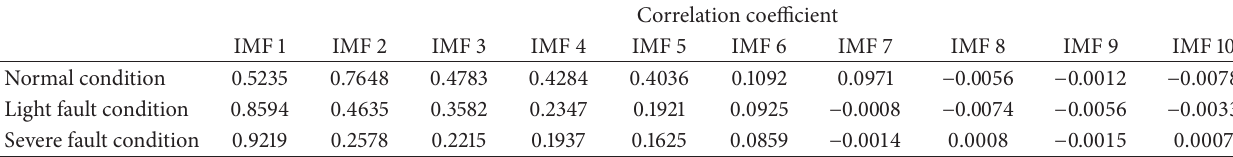
Table 1: Correlation coefficients between filtered signals and each IMF.